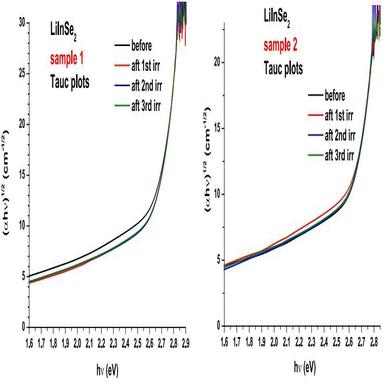
Tauc plots of absorbance spectra of the two LiInSe2 samples before and after each irradiation.